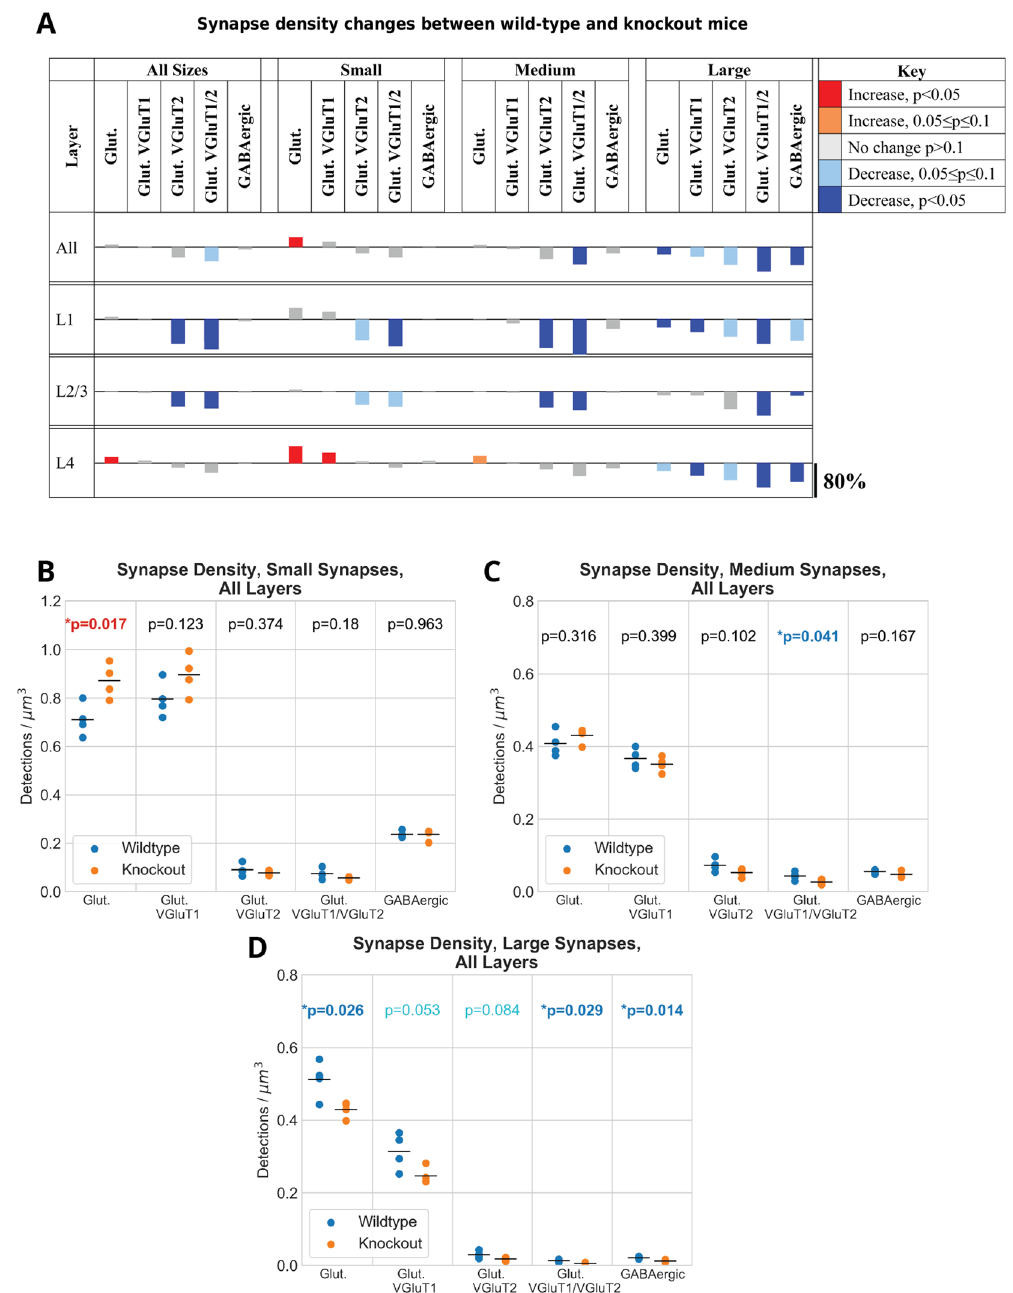
Figure 5. Changes in synapse densities across layers. ( A ) Summary table showing the synapse types that have a significant increase or decrease in synapse density between wild-type and knockout mice. Each row shows plots of the percentage difference in density between the wild-type and knockout mice. Plots are color-coded to indicate direction of change and statistical significance. ( B – D ) Differences in synapse density for different synapse types for three expected synapse